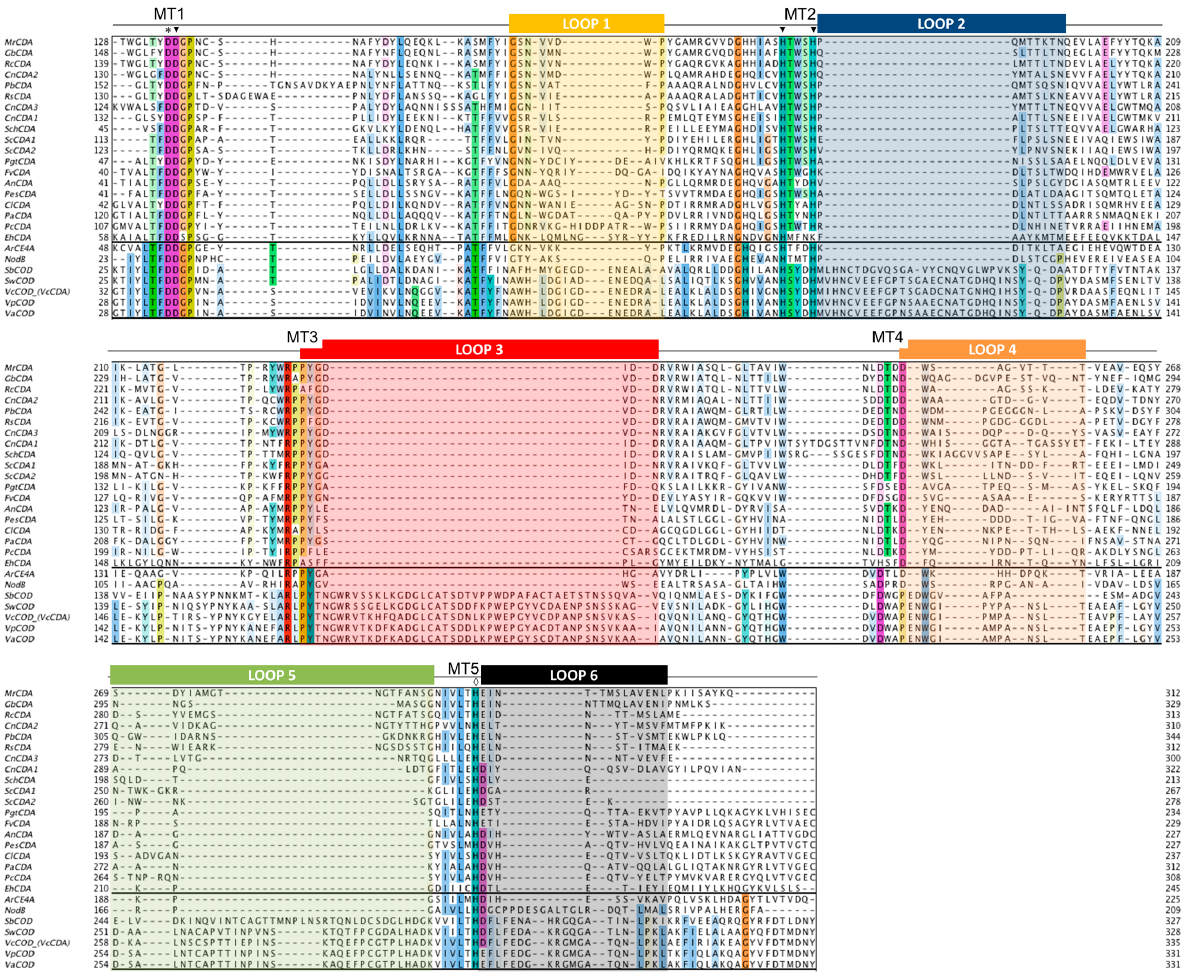
Figure 3. Multiple sequence alignment of the CDA enzymes listed in Table 1. Loops are highlighted with colored boxes according to [69]. Conserved catalytic motifs are labelled MT1-5. The ‘His-His-Asp’ metal binding triad ( (cid:72) ), catalytic base ( * ), and catalytic acid ( ♦ ) are